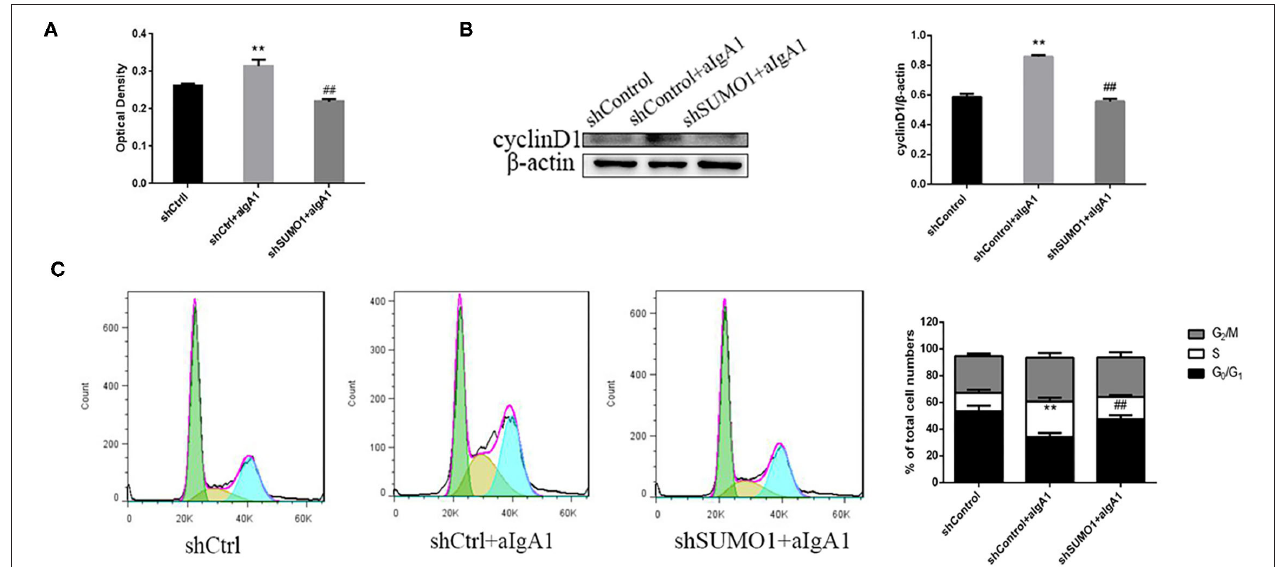
FIGURE 5 | Blockading SUMO1 in mesangial cells suppresses cell proliferation and extends cell cycle stimulated by aIgA1. (A) CCK8 analysis of mesangial cells proliferation among groups transfected with control or shSUMO1 plasmids and stimulated by aIgA1. (B) Western blot analysis for Cyclin D1. (C) Cell cycle of mesangial cells was analysised by Flow cytometry. Cells were transfected with control or shSUMO1 plasmids and stimulated by aIgA1. Data were presented as mean ± SD ( n = 10). ** p < 0.01 vs. shControl, ## p < 0.01 vs. shControl + aIgA1 group.